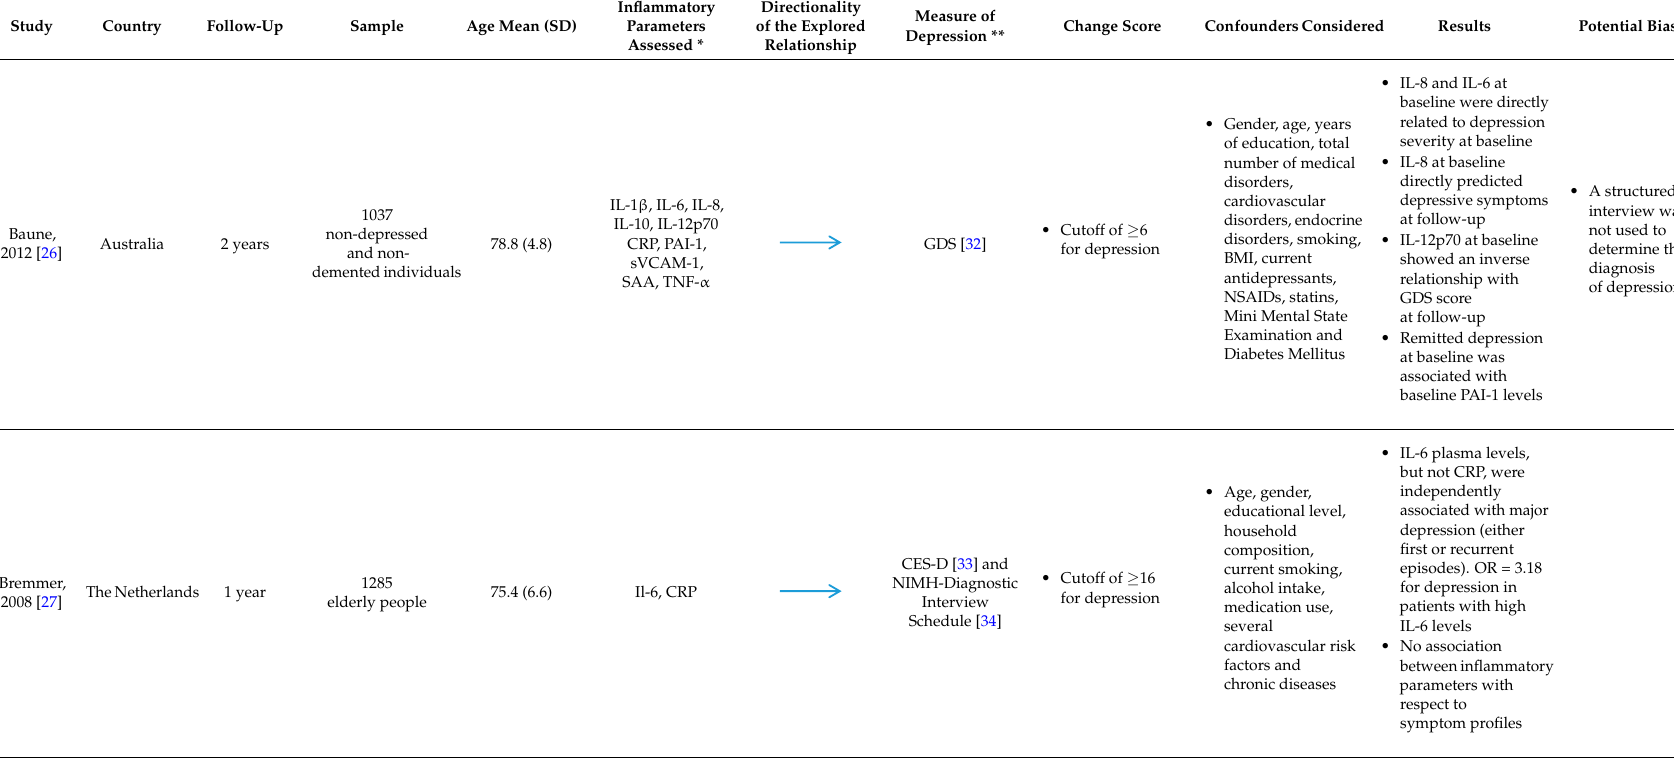
Table 1. Main characteristics of cohort studies included in the review.